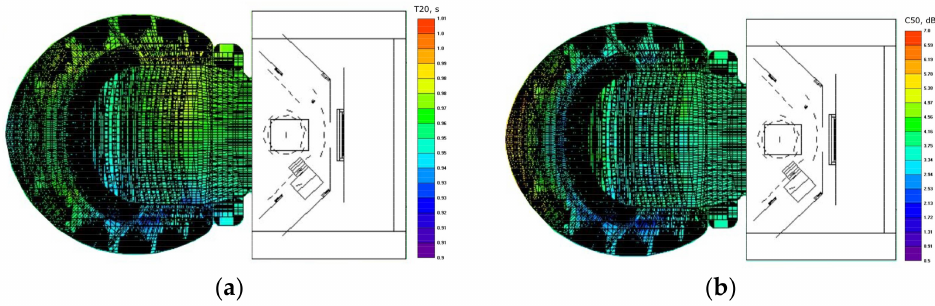
Figure 13. Spatial distribution at 500 Hz of Act I without any audience, related to reverberation time ( a ) and speech clarity index ( b